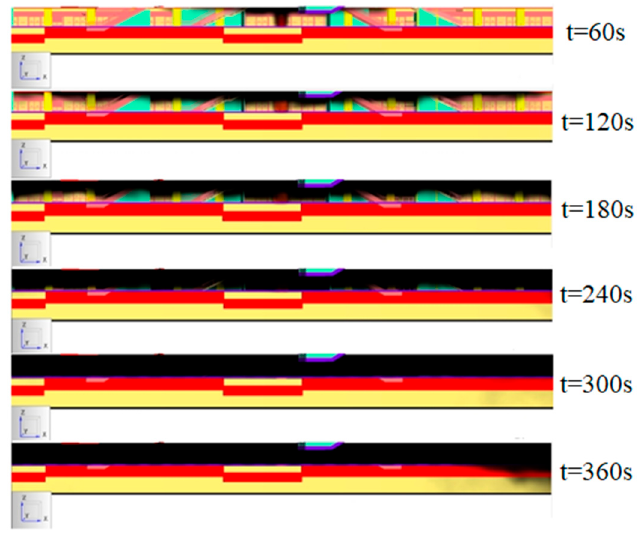
Figure 10. Fire smoke spread degrees in the middle of the platform.